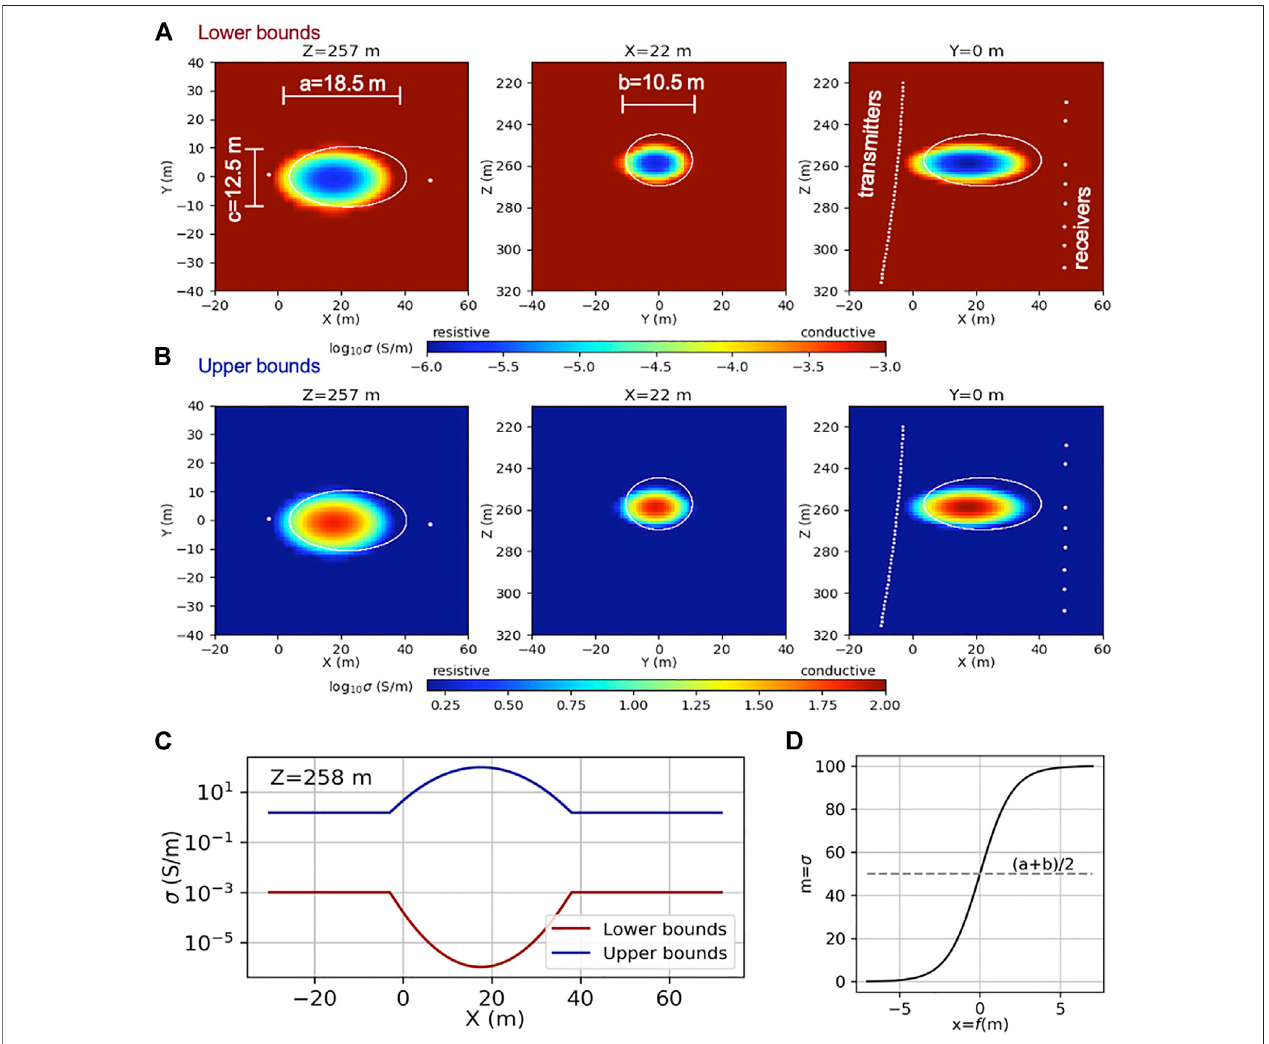
FIGURE 4 | (A) : Plume imaging for CaMI.FRS. Spatially variable lower and upper model parameter bounds constrain inversions for an ellipsoidal CO 2 plume. Variableboundsoccuroveranellipsoidthatisdifferentinshapeandcentercoordinatestothetrueplume,thelatterindicatedbywhitecontoursandthesemiaxeslengths ( a,b,c ). Crosswell instrument locations are projected. Lower parameter bounds span the electrical-conductivity range from 10 − 6 to 10 − 3 S/m. (B) : Upper bounds range from1.5to100 S/m. (C) :Lowerandupperboundsarepairedsuchthatconstraintsopenupwhentraversingtheellipsoidaltargetregion,hereshownforthex-axis at (y,z) = (0, 258) m. (D) : The logarithmic transformation function of Eq. 4 is exempli fi ed for the bound interval [ a , b ] (cid:2) [ 10 − 6 , 100 ]